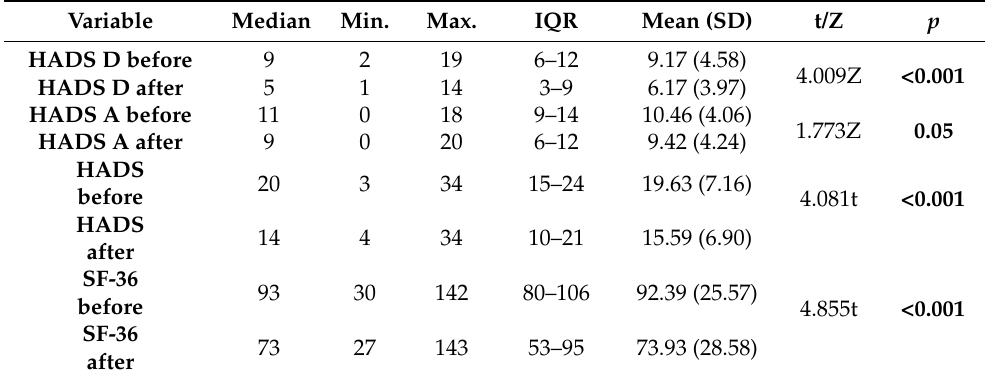
Table 4. Descriptive statistics of the variables and the assessment of the significance of differences between the two